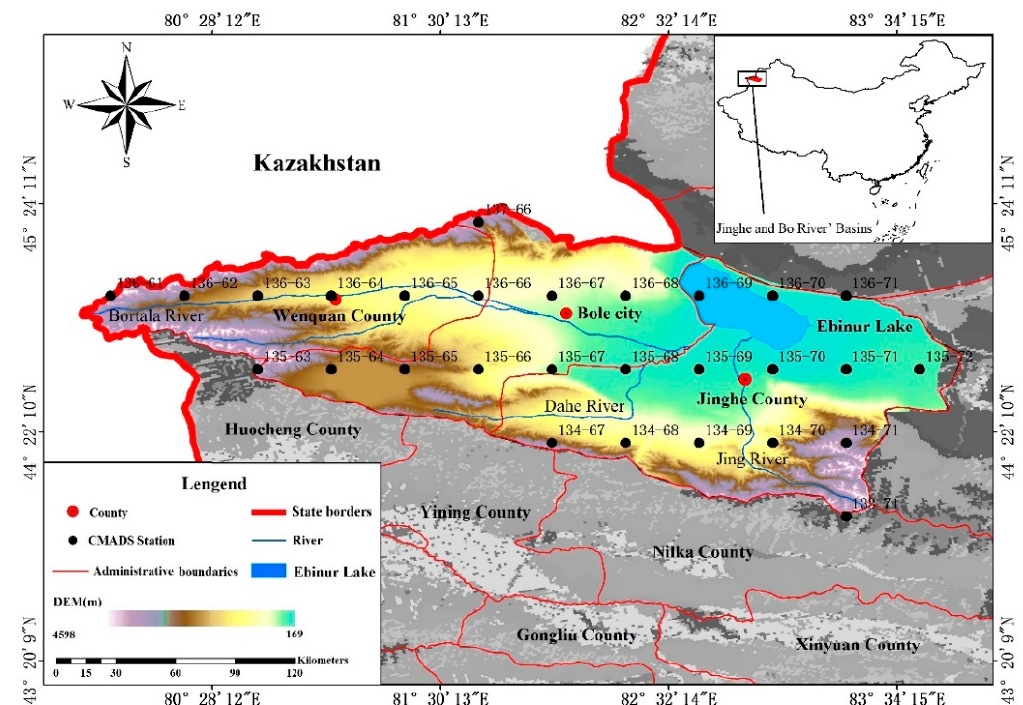
Figure 1. Location of Jinghe and Bortala River Basins (JBR).